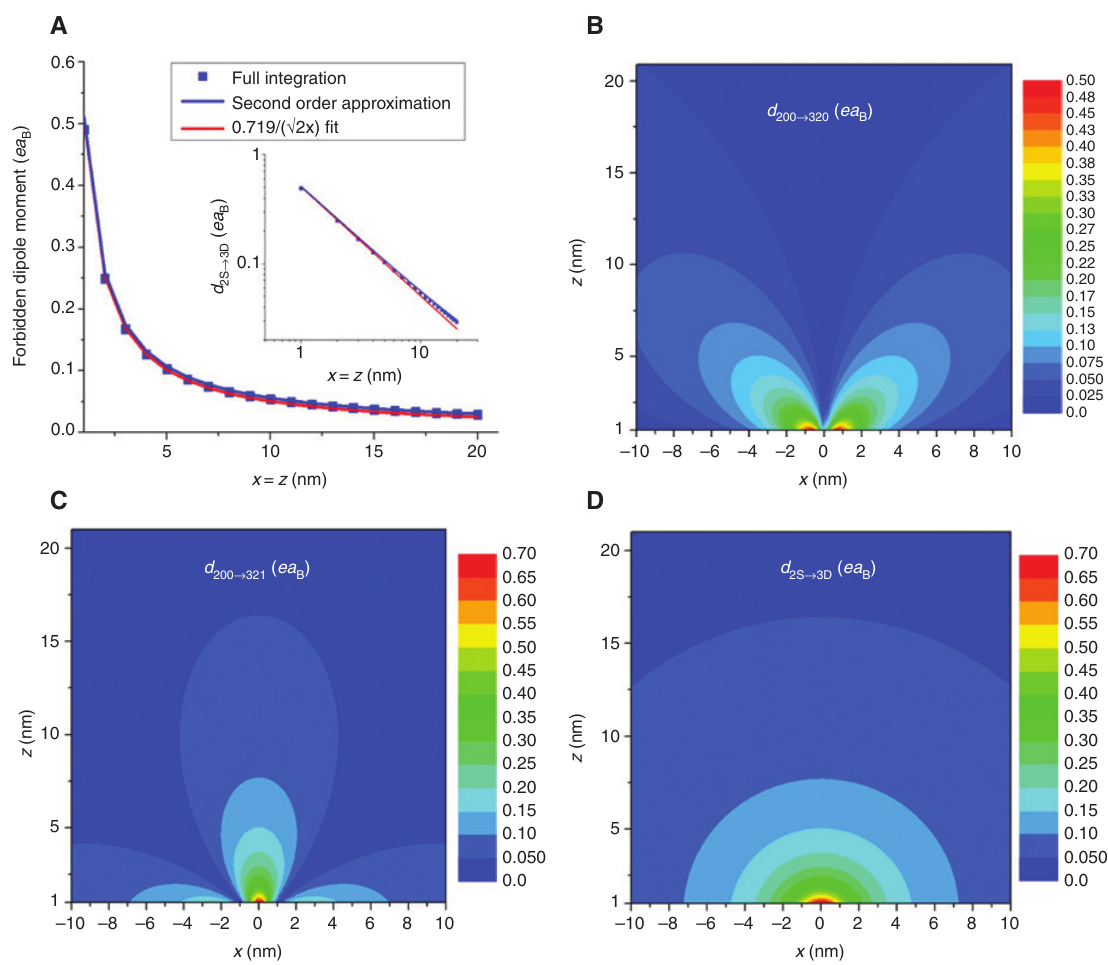
Figure 2: (A) Total forbidden dipole moment along the x = z line, calculated from the second-order Hamiltonian (blue line), the full interaction Hamiltonian (blue squares), and a fit to the analytical expression 0.719/ 2 z (red line). (B) Contour plot of the forbidden ψ ψ H = 320 int 200 transition moment where a is the Bohr radius, in a 20 nm by 20 nm area starting from z = 1 nm. in units of ea d B B → 200 320 ( , ) E x z 0 0 0 (C) Contour plot of the forbidden transition moment (D) Contour plot of the total forbidden transition moment The cylindrical symmetry is largely